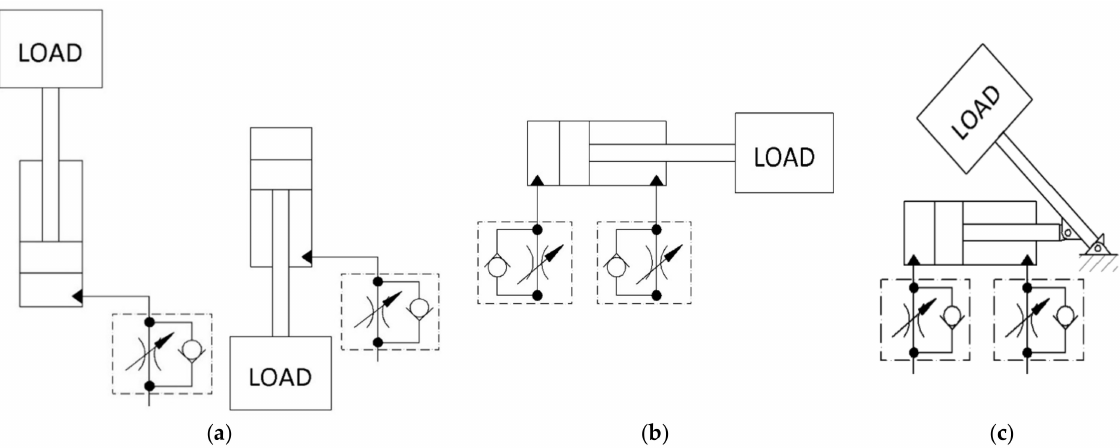
Figure 10. Throttle check valve (Thr) application: ( a ) meter-out single-acting actuator; ( b ) meter-in double-acting actuator; ( c ) meter-out double-acting actuator.